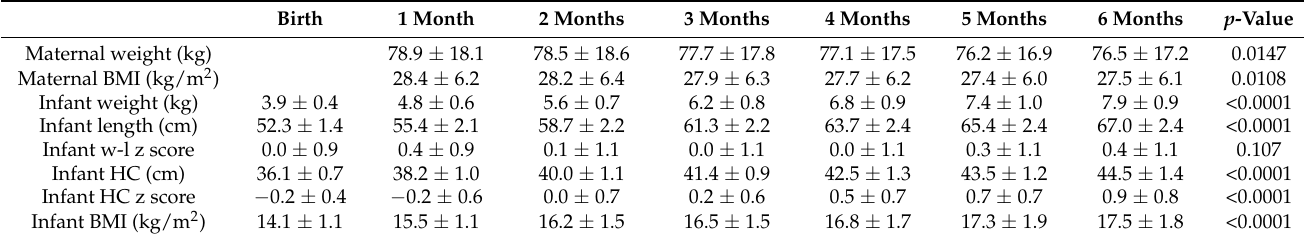
Table 2. Mean maternal and infant growth characteristics from months one to six exclusive